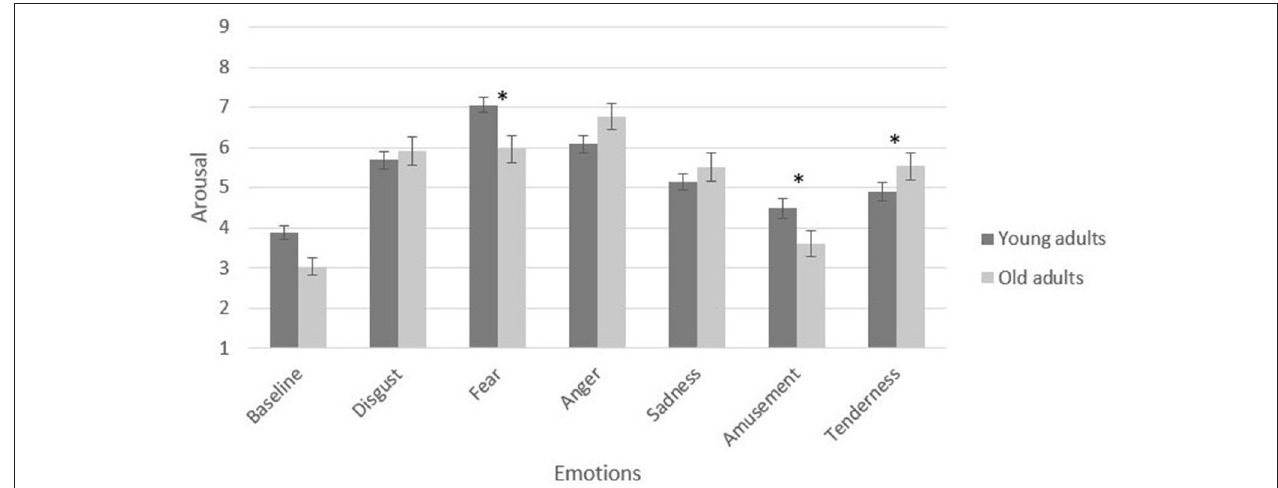
FIGURE 3 | Self-reported arousal of participants by film condition and age group. Participant-level means of baseline and emotional target categories. Error bars depict standard error (SE) values. * p < 0.05.